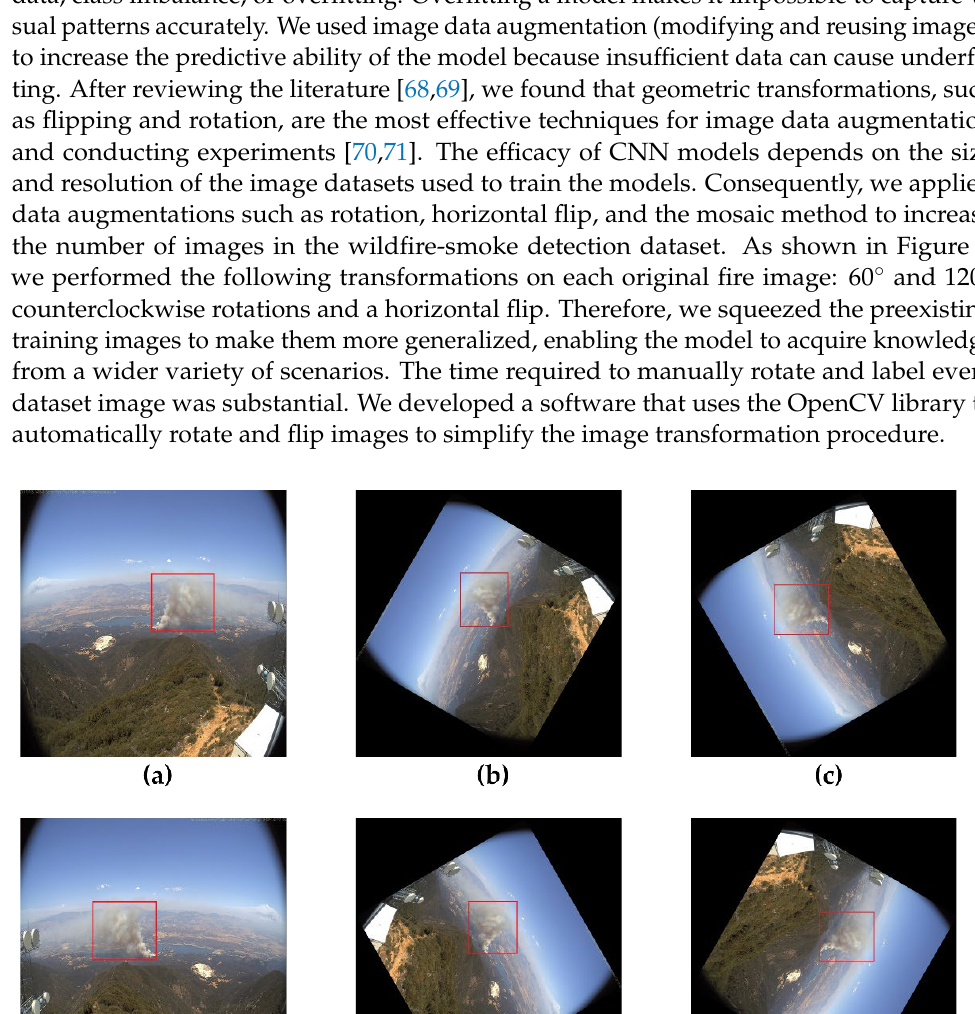
Figure 8. Image data augmentation using geometric transformations: ( a ) original image; ( b ) 60° rotation; ( c ) 120° rotation; ( d ) horizontal flipping of original image; ( e ) horizontal flipping of 60° rotated image; ( f ) horizontal flipping of 120° rotated image.